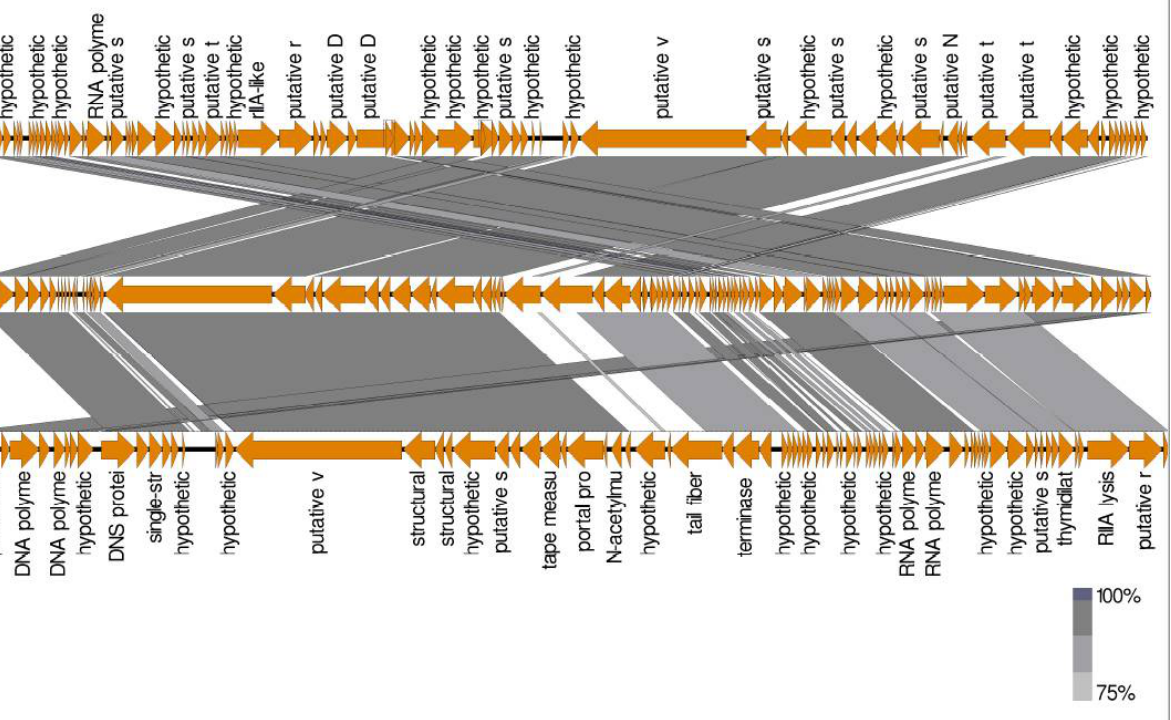
Figure 13. Comparison of ORFs between Escherichia phage ST4 ( middle ) and the most closed phages Escherichia phage vB EcoP PhAPEC7 ( above ) and Escherichia phage PGN829.1 ( below ). Analysis was performed using EasyFig software version 2.2.5. Table 7. Genes occurred in Escherichia phage ST4 and not present in Escherichia phage PGN829.